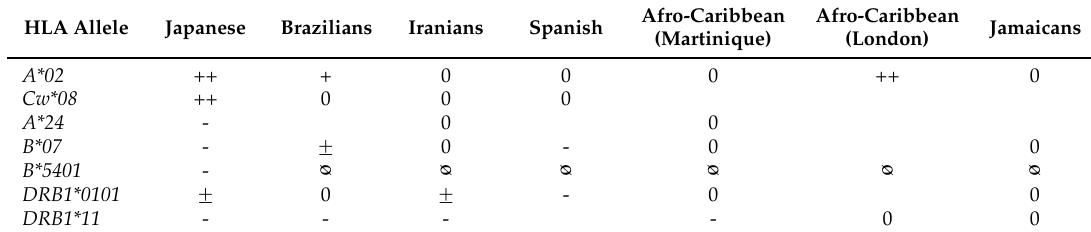
Table 1. Distribution of human leukocyte antigen (HLA) haplotypes according to risk of HTLV-1-associated myelopathy/tropical spastic paraparesis (HAM/TSP) development.